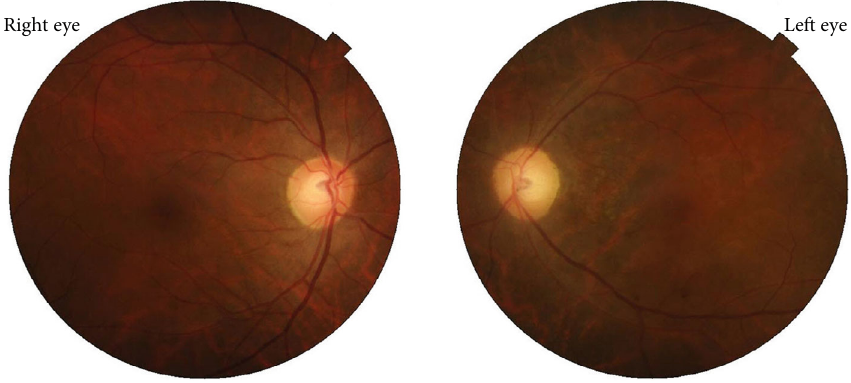
Figure 8: Fundus photo at the end of two years follow-up showing dull foveal re fl ex in both eyes.